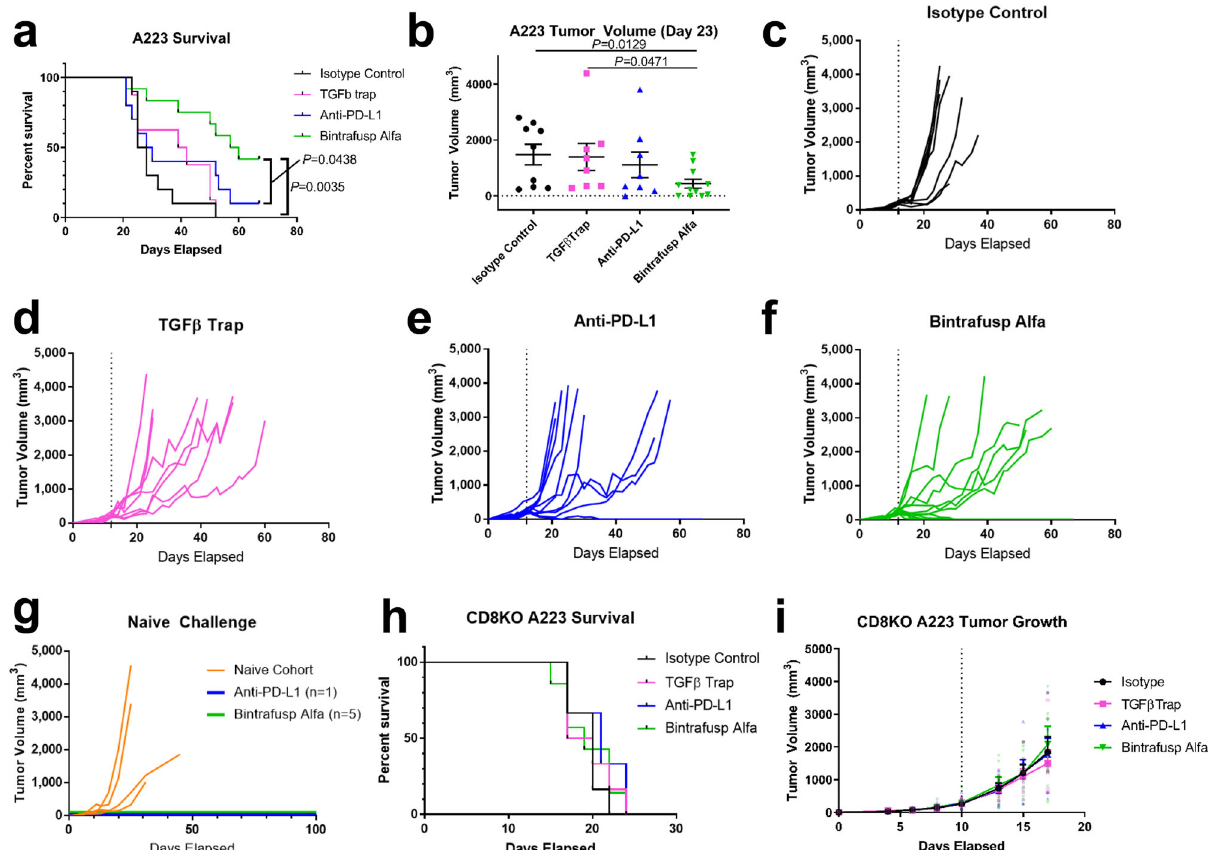
Fig. 3 Bintrafusp alfa, a bifunctional fusion protein targeting TGF β and PD-L1, durably eradicates A223 tumors and produces distinct responder and nonresponder phenotypes. a Survival post-injection of C57BL/6 mice bearing A223 tumors that were treated with isotype control ( n = 8), TGF β trap control ( n = 8), anti-PD-L1 ( n = 10), or bintrafusp alfa ( n = 12) 3×/week for 2 weeks. b Tumor volume on day 23 post-transplant for mice in ( b ). c